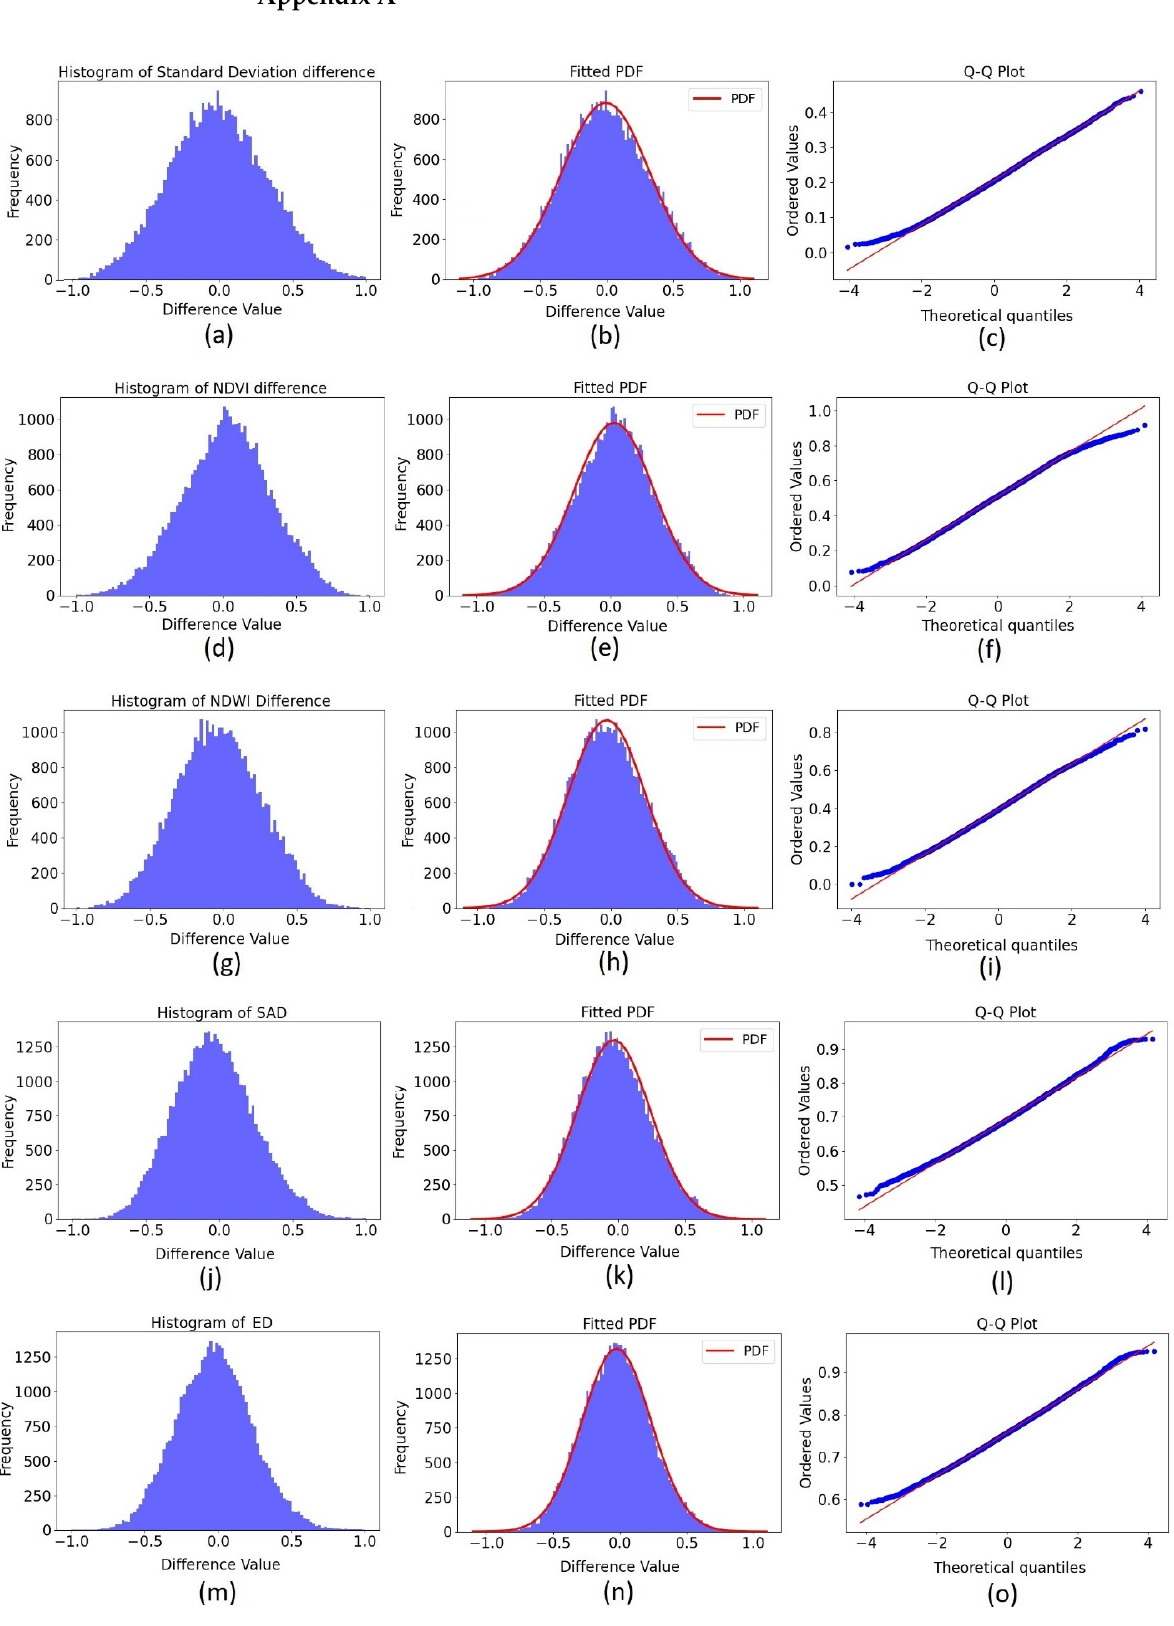
Figure A1. Normality test procedure for 2019’s change images. ( a , d , g , j , m ) The histogram of the change images. ( b , e , h , k , n ) The fitted PDF. ( c , f , i , l , o ) The Q-Q plot of the change images.